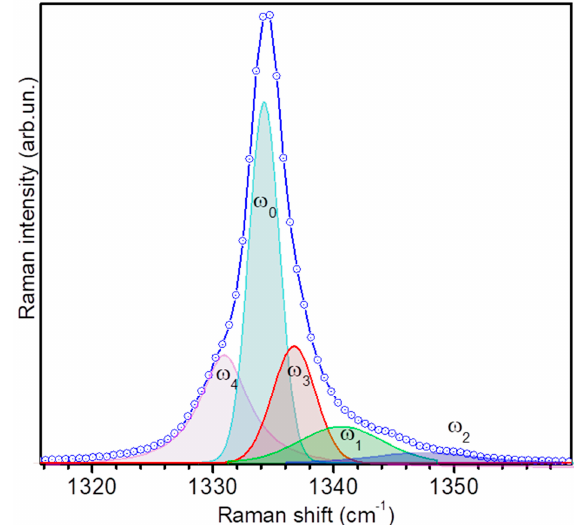
Figure 6. Example of decomposition of the Raman spectra taken near the outer edge of the Vickers indent in (111) synthetic diamond single crystal.